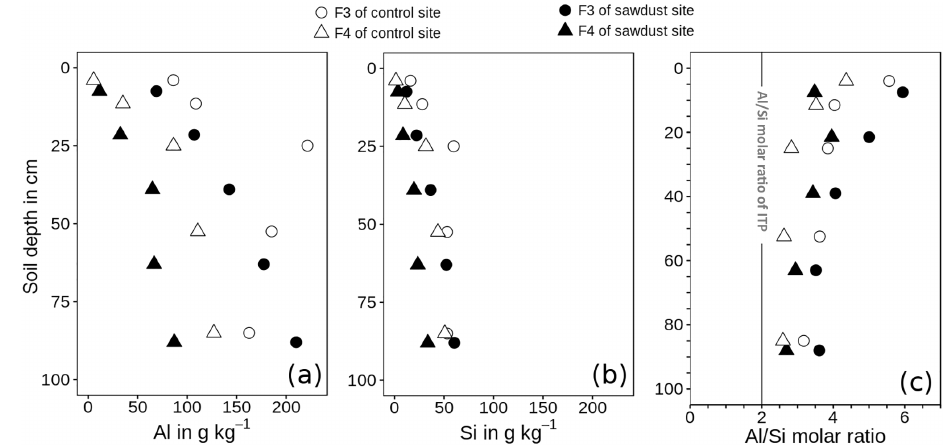
Figure 6. Concentration of acid–oxalate-extractable aluminium (Al, a ) and silica (Si, b ) and Al / Si molar ratios (Al / Si, c ) of fractions of densities between 1.6 and 2.0gcm − 3 (F3) and >2.0gcm − 3 (F4). The metal concentrations are normalized to the mineral portion of the fraction, assuming that the mass of OM is 2 times the mass of OC (Sollins et al., 2006). ITP represents imogolite-type phases.